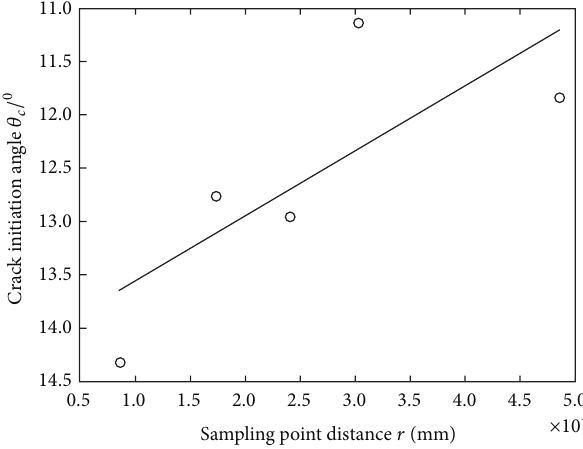
Figure 8: Displacement extrapolation curve for LY8